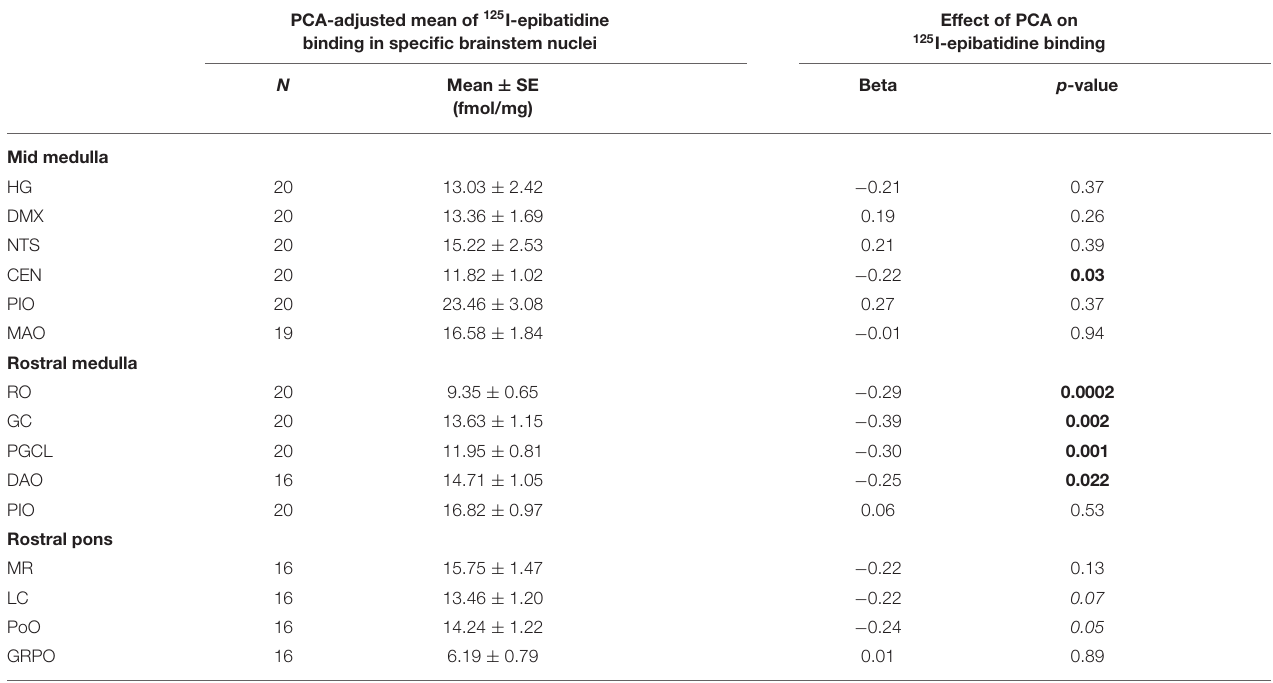
TABLE 4 | Effect of PCA in Pre- and Post-KCOD controls combined on 125 I-epibatidine binding in brainstem nuclei. PCA-adjusted mean of 125 I-epibatidine binding in specific brainstem nuclei